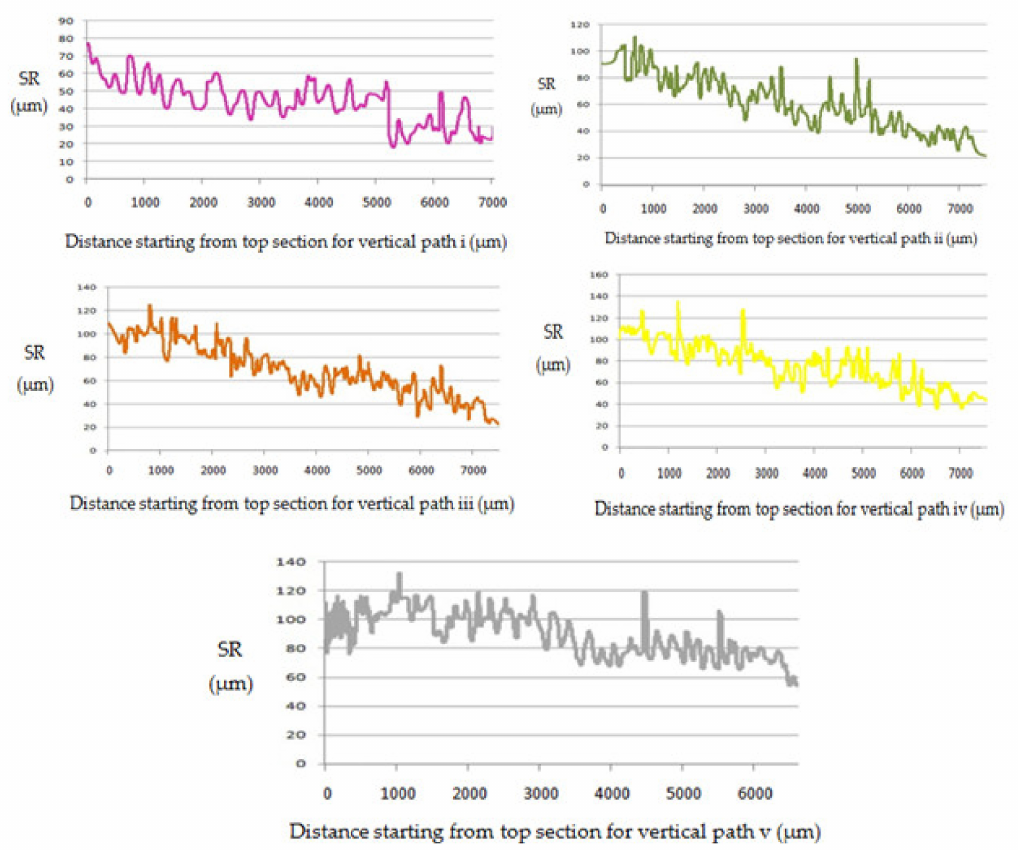
Figure 6. Roughness measurement along vertical